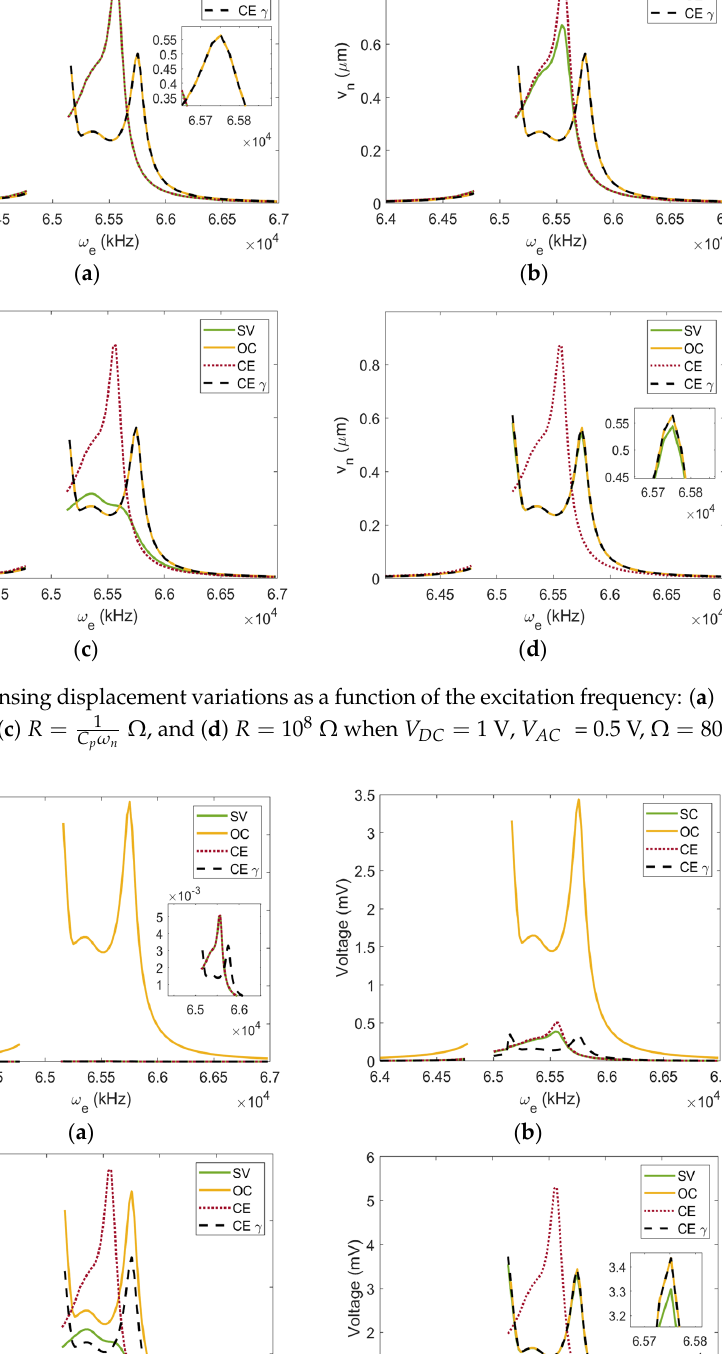
Figure 8. Driving displacement variations as a function of the excitation frequency: ( a ) 𝑅 = 10 (cid:2871) Ω , Ω , and ( d ) 𝑅 = 10 (cid:2876) Ω when 𝑉 (cid:3005)(cid:3004) = 1𝑉 , 𝑉 (cid:3002)(cid:3004) = 0.5 V, Ω = 80 (cid:3045)(cid:3028)(cid:3031) ( b ) 𝑅 = 10 (cid:2873) Ω , ( c ) 𝑅 = (cid:2869) (cid:3004) (cid:3291) (cid:3104) (cid:3289) 0.01 .